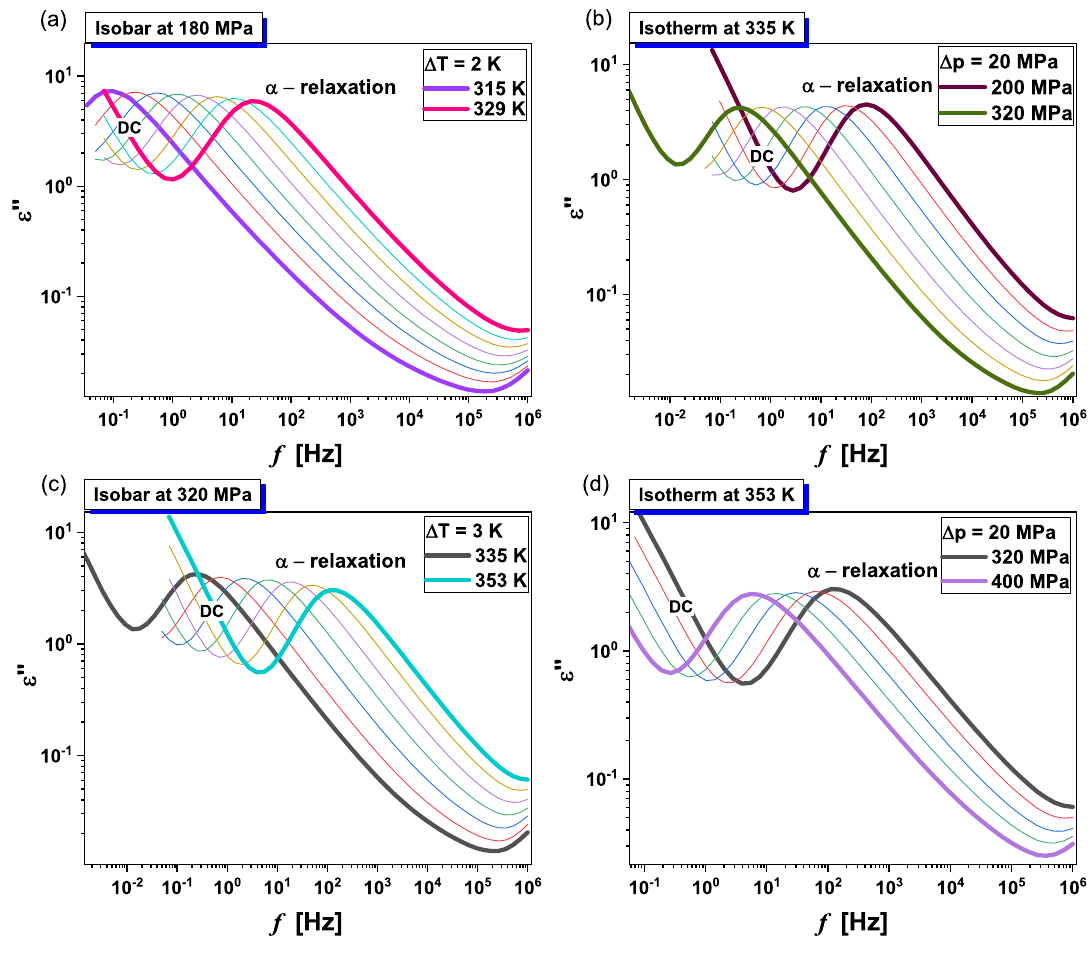
Figure 5. Representative dielectric loss spectra measured for MLT at isobaric [panels ( a ) and ( c )] and isothermal [panels ( b ) and ( d )]